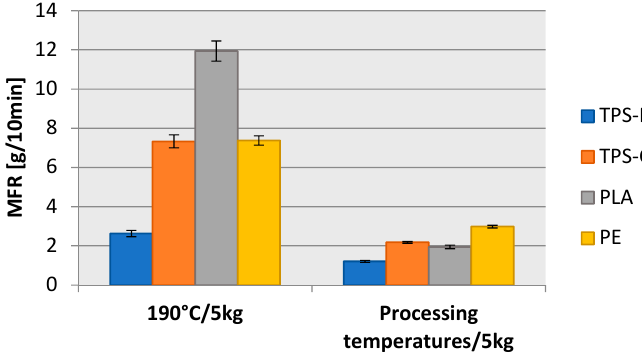
Figure 4. Measurements of melt flow rate of tested materials at 190 °C (cut off times: PLA and TPS-C—5 s, LDPE—10 s, TPS-P—15 s) and processing temperatures (cut off times: LDPE—15 s, PLA—30 s, TPS-C—15 s, TPS-P—30 s).